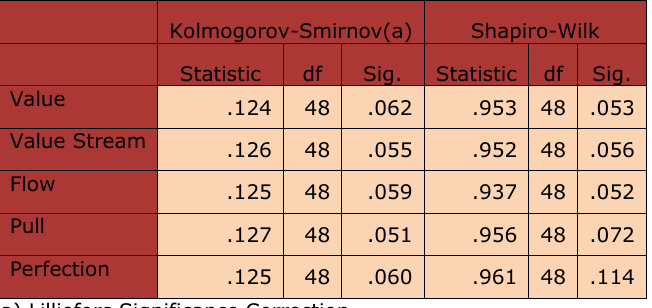
Table 11. Output of Kolmogorov-Smirnov and Shapiro-Wilk Test for Checking the Normality of the Lean